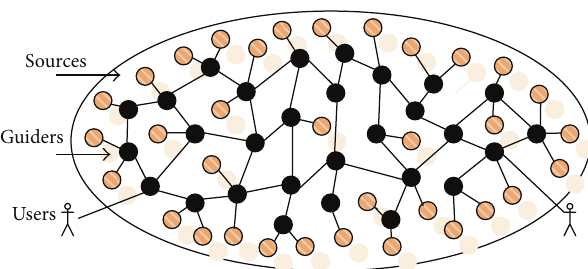
Figure 8: The schematic topology of the experimental network (sources are more than guider